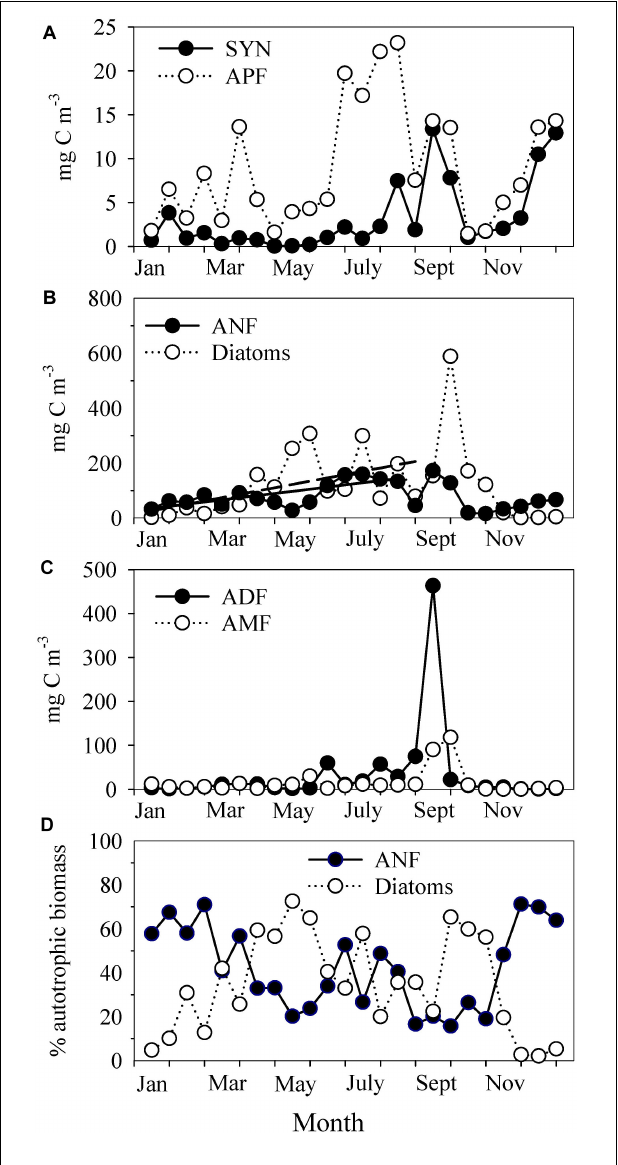
FIGURE 5 | Time series of (A) the biomass of Synechococcus (SYN) and autotrophic picoflagellates (APF), (B) the biomass of autotrophic nanoflagellates (ANF) and diatoms, (C) the biomass of autotrophic dinoflagellates (ADF) and other autotrophic microflagellates (AMF), and (D) the contributions of ANFs and diatoms to the total AB. The continuous line in (B) depicts the seasonal increase in ANF: Y = (27 ± 17) + (7 ± 2)X; r 2 = 0.56; n = 15; p = 0.001. The dashed line shows the seasonal increase in diatoms: Y = ( − 3 ± 45) + (15 ± 5)X; r 2 = 0.46; n = 15; p = 0.009. The values were averaged every half-month ( n = 3–5) to remove short-term